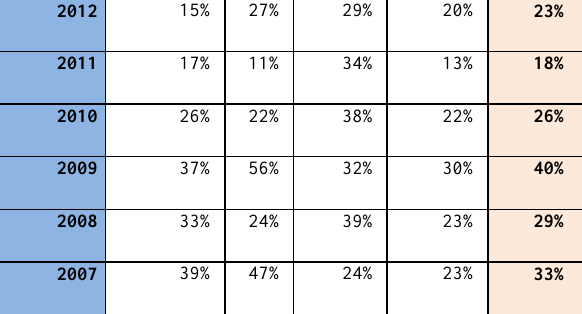
Table-8/a: Total Funds Collected, 2007-2013 (1000TL)